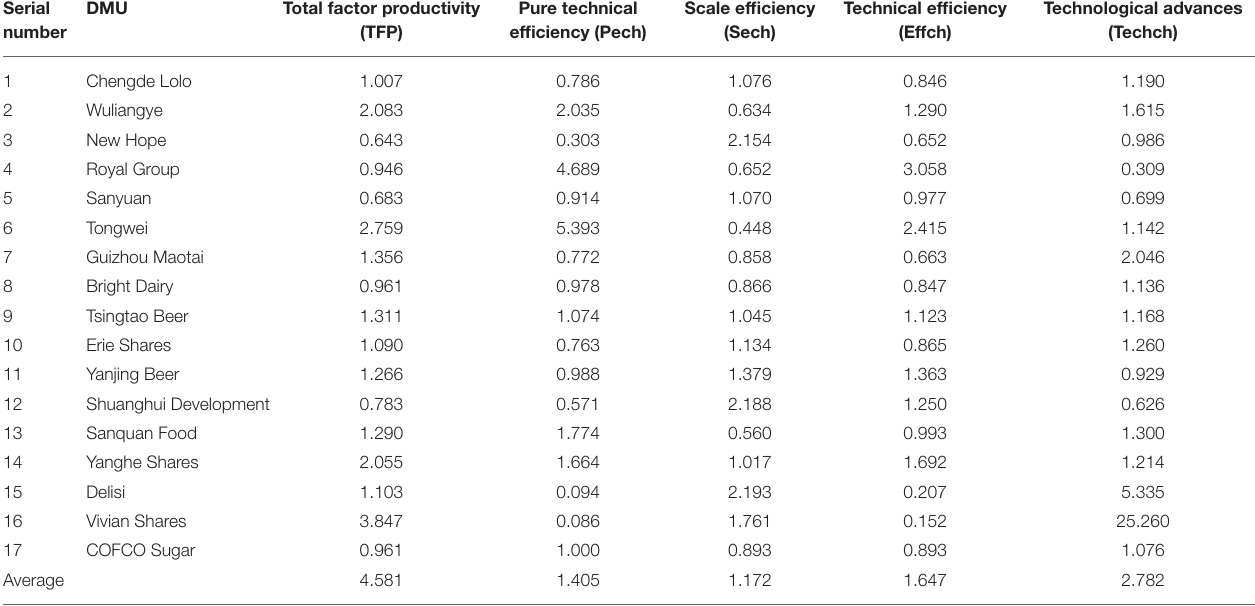
TABLE 6 | TFP index and its decomposition of social responsibility efficiency of sample companies in the 17 sample enterprises in the food industry in 2020. Serial number